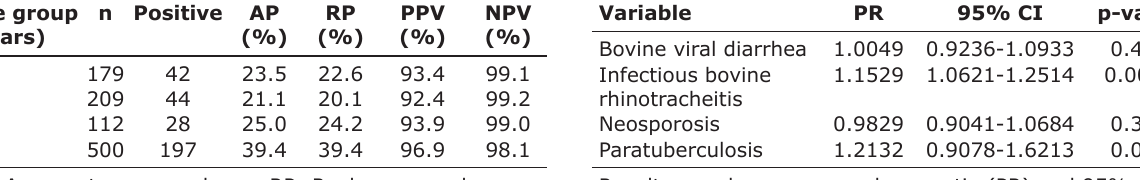
Table-2: AP and RP of BLV by age group in bovine from the municipality of Sotaquirá, Boyacá. Age group (years)